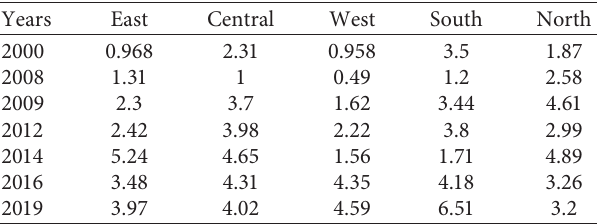
Figure 17: The macroeconomy has entered an improvement stage. Table 10: Differences in TFP between the three main regions in the central and western